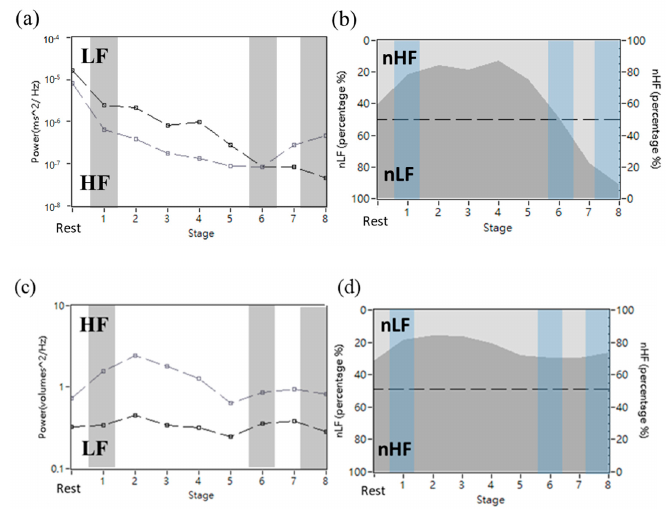
Figure 7. HRV and SVV power spectrum in the rest and exercise stages. ( a , b ) were HRV power spectrum. ( c , d ) were SVV power spectrum. ( a , c ) had LF and HF power. ( b , d ) were processed by normalization and were expressed as percentage units. Example from patient #25.